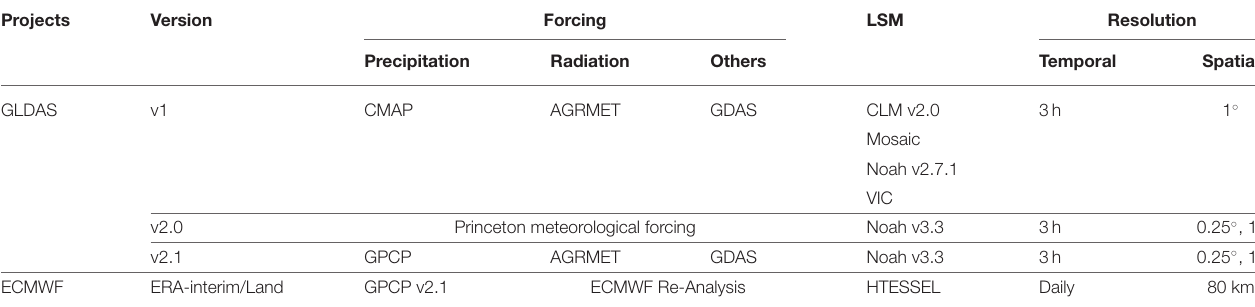
TABLE 1 | Details of the Land Surface Model (LSM) outputs used in this study.